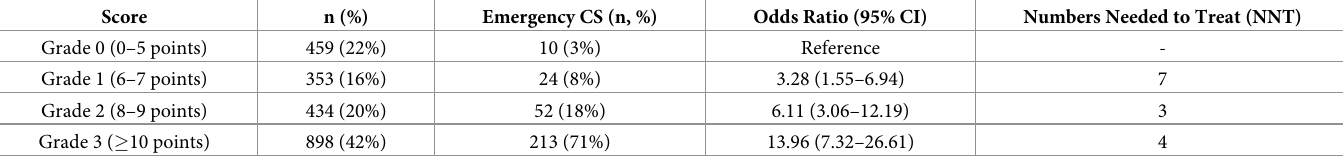
Table 4. Emergency CS prediction risk scoring